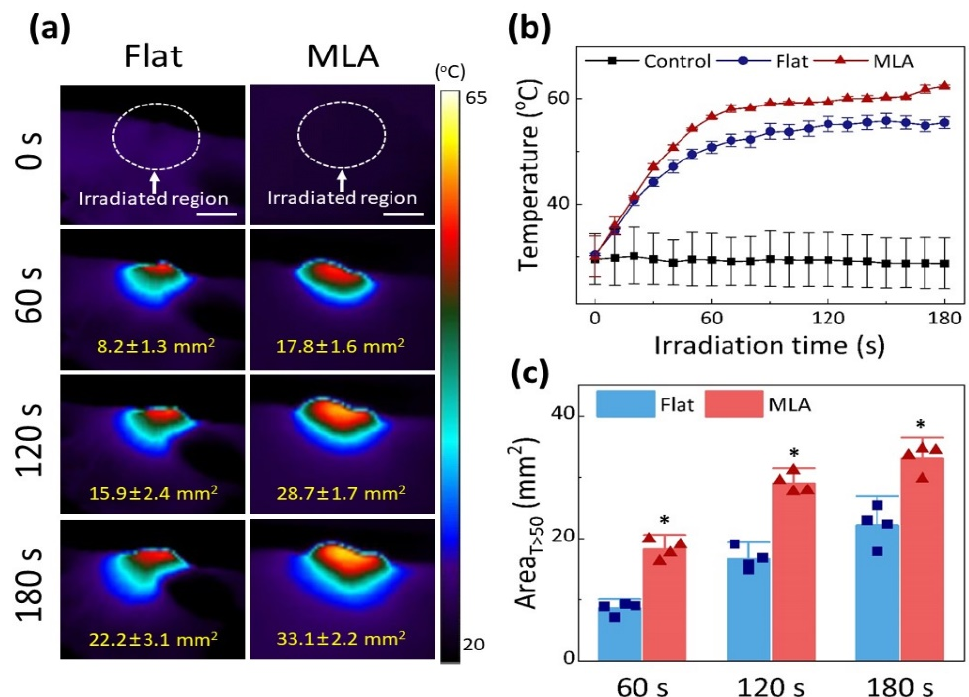
Figure 4. In vivo thermographic measurements with Flat-based and MLA-assisted irradiations at 2 W/cm 2 irradiance for 180 s (dye concentration = 300 µg/mL in PBS): ( a ) IR images of CT26 tumor- bearing mouse model captured at various irradiation times, ( b ) temporal developments of maximum temperature measured from irradiated area in tumor (white dashed lines in ( a )), and ( c ) comparison of treatment areas with temperature of 50 °C or higher (T > 50) at three irradiation times ( n = 4 per group; scale bar = 5 mm; * MU p < 0.005 vs. Flat).